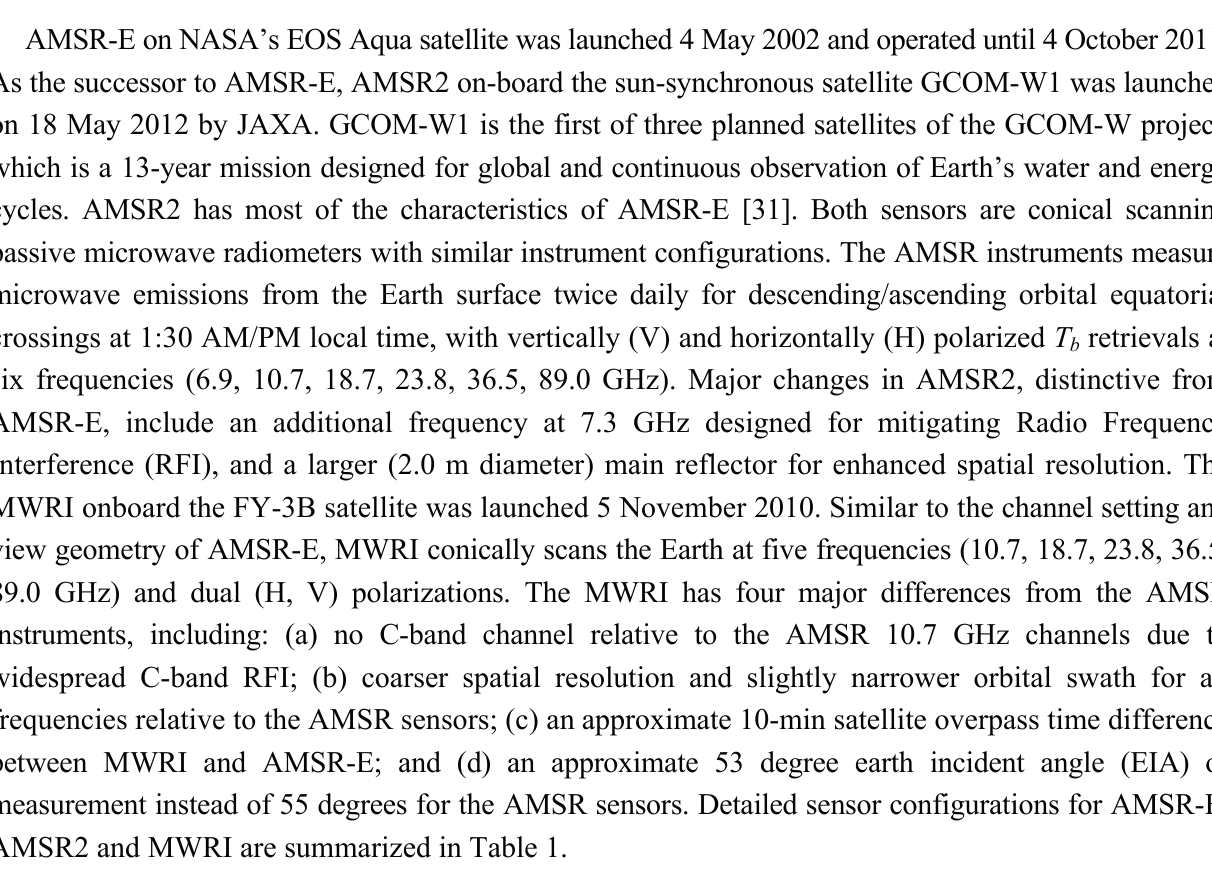
Table 1. Satellite microwave sensor configurations used in this